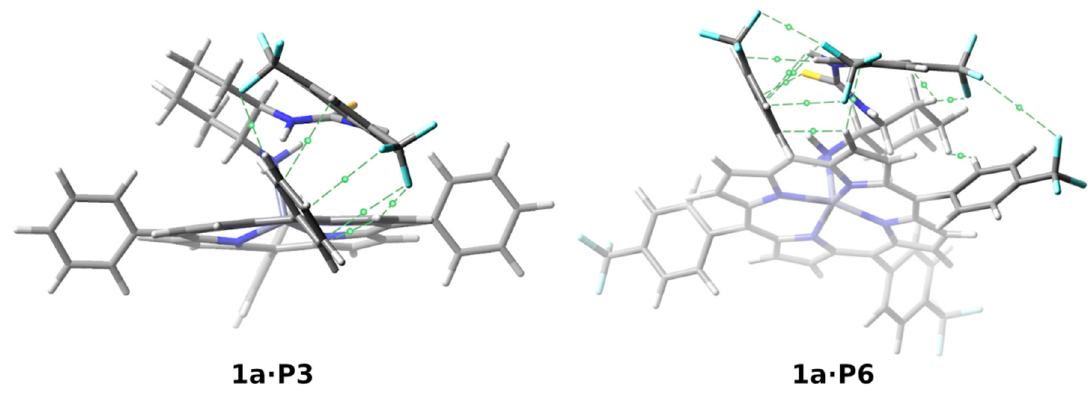
Figure 6. Models for the dominant conformers of complex 1a · P3 ( left ) with face-to-face and complex 1a · P6 ( right ) with T-shaped orientation of aryls from host–guest. Color code for atoms: C, gray; H, white; N, blue; S, yellow; F, light ‐ blue.